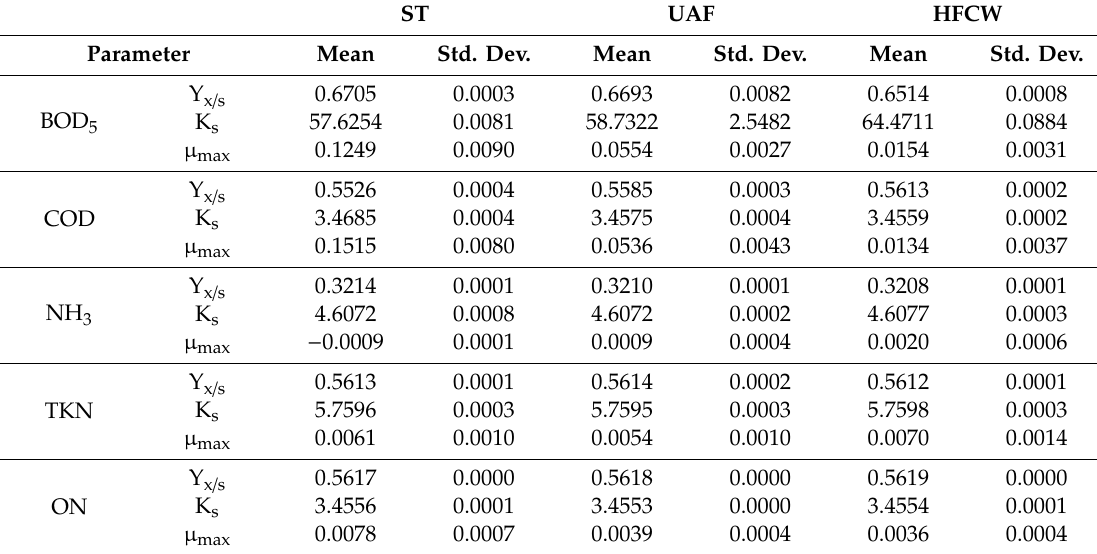
Table 6. Mean values and standard deviation for Y x / s (mg biomass / mg substrate), K s (mg / L), and µ max (h − 1 ) obtained from mass balance